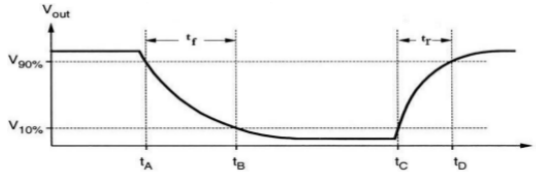
Figure 2: Output voltage rise time ( t r ) and fall time ( t f ) .